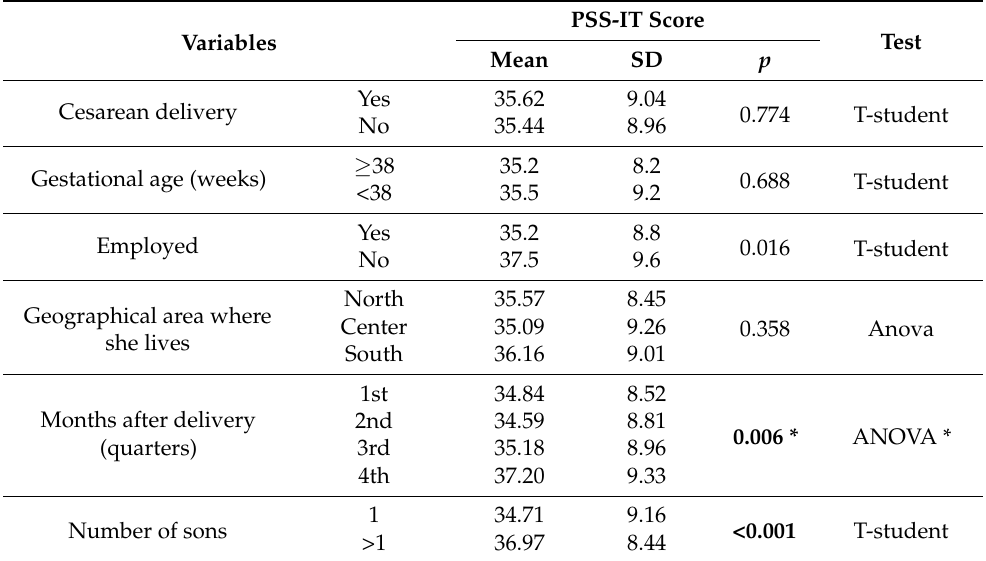
Table 3. Univariate analysis of PSS-IT score versus the variables